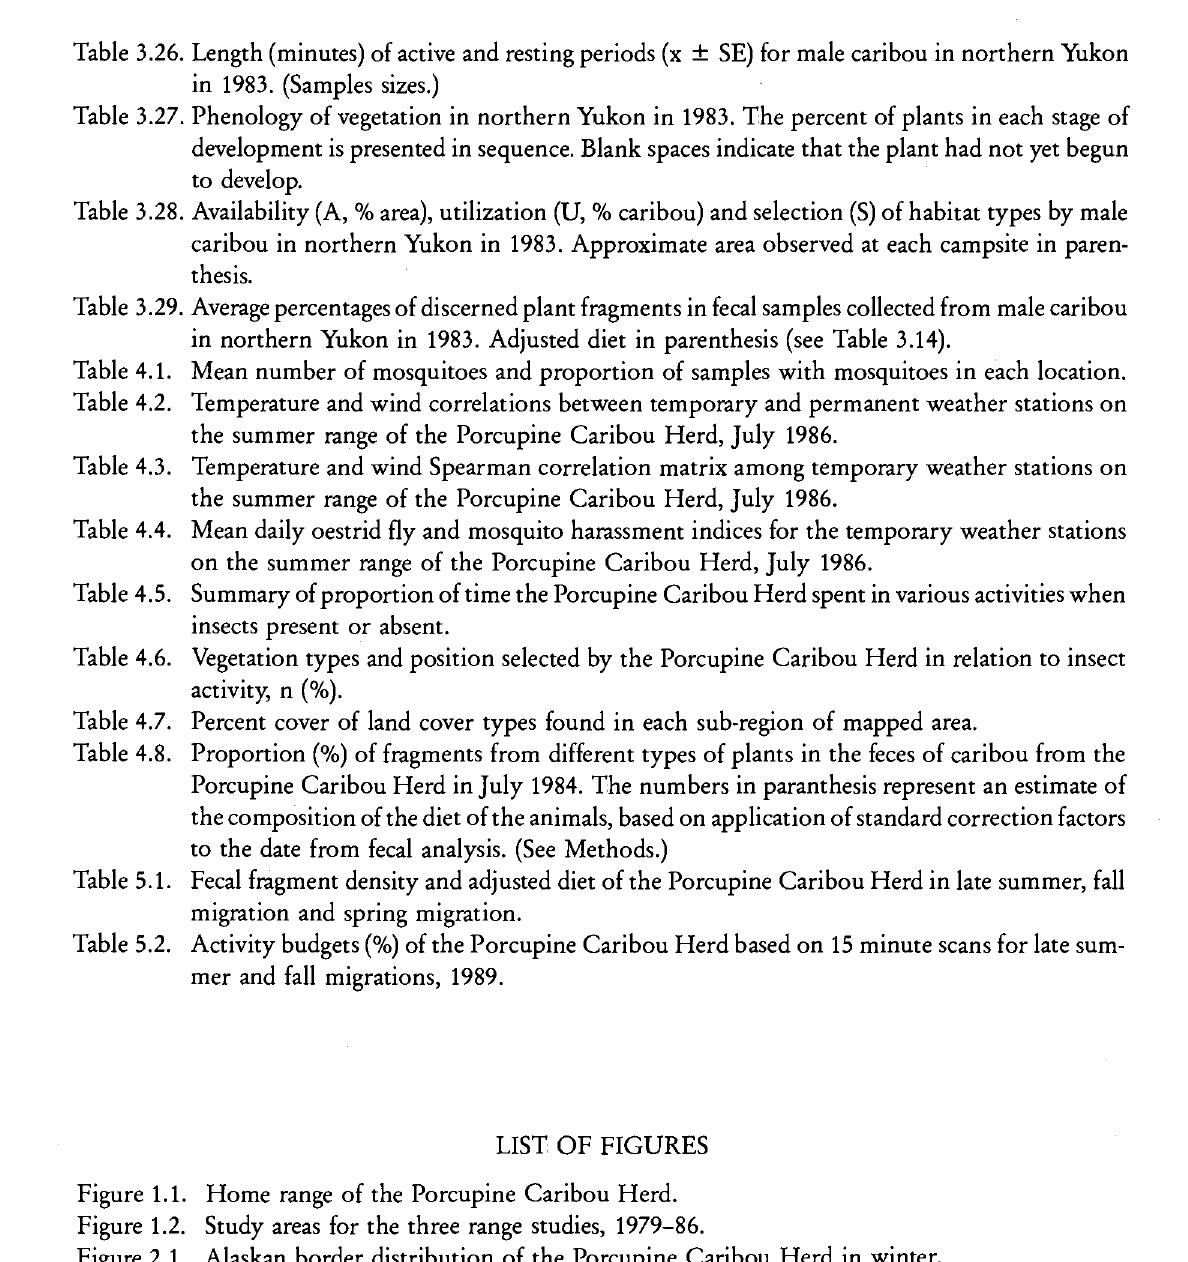
Figure 1.1. Home range of the Porcupine Caribou Herd. Figure 1.2. Study areas for the three range studies, 1979-86. Figure 2.1. Alaskan border distribution of the Porcupine Caribou Herd in winter. Figure 2.2. Richardson Mountain distribution of the Porcupine Caribou Herd in winter. Figure 2.3. Ogilvie/Hart distribution of the Porcupine Caribou Herd in winter. Figure 2.4. Whitestone/Miner distribution of the Porcupine Caribou Herd in winter. Figure 2.5. Winter range study area showing the snow stations and snow regions. Figure 2.6. Reindeer lichen biomass versus range type. Figure 2.7. Lichen biomass versus stand age. Figure 2.8. Percent of animals lying from 15 minute scans in relation to hours after sunrise for the six study periods. Figure 2.9. Cluster analysis of activity budgets of caribou in north-central Yukon. Figure 2.10. Cluster analysis of proportional use of active periods by caribou of north-central